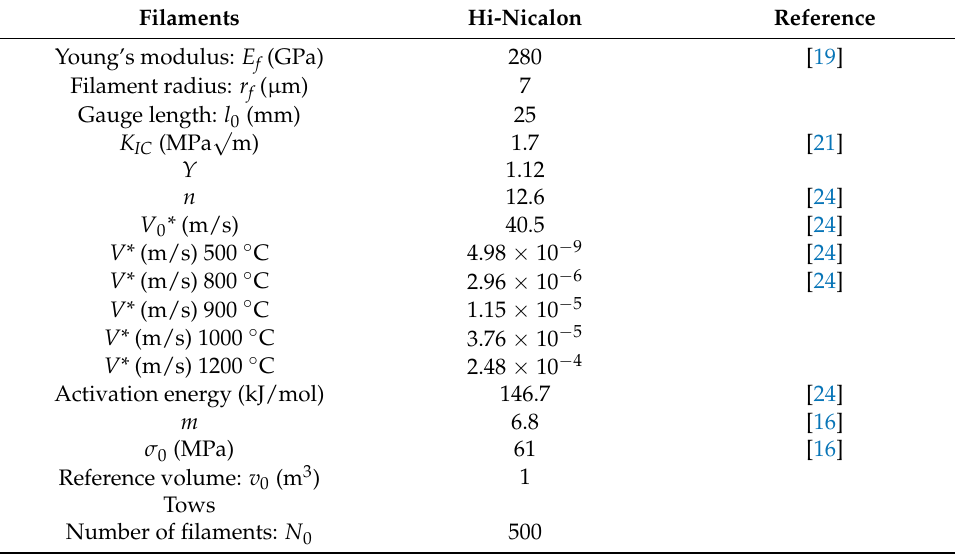
Figure 1. Predicted statistical distributions of lifetimes at 500 °C under constant force (initial stress on filaments 600 MPa) and equal load sharing for Hi Nicalon filaments of a tow: n + 0 stands for failure one after another, n + 10 for failure of groups of 10 filaments, and X2 for failures of groups of filaments with size doubled at each step. Additionally indicated is the failure probability ( α t = 0.11) of critical filament. Failure probability defines a filament with respect to the cumulative distribution function for strengths [21]. Table 1. Hi Nicalon filament and tow